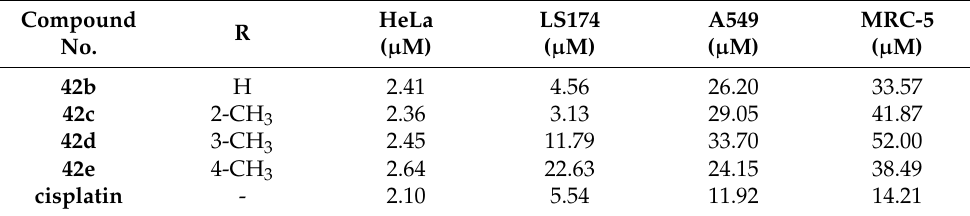
Table 35. In vitro cytotoxic activities of quinone based chalcone hybrid compounds 42 ( b – e ). Compound